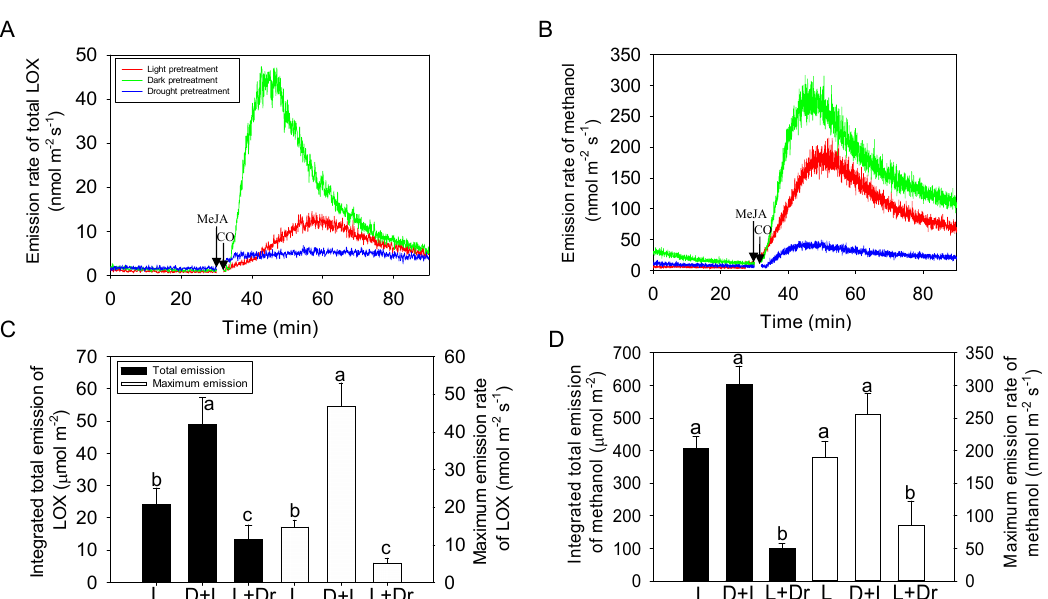
Figure 4. Sample emission time-courses of LOX compounds ( A ) and methanol ( B ) and corresponding average ± SE ( n = 3) total emission and maximum emission rates of LOX compounds ( C ) and methanol ( D ) in Cucumis sativus leaves following exposure to 20 mM MeJA at time 30 min. The leaves were subjected to three pretreatments, leaves illuminated before treatment (light pretreatment), leaves darkened for 30 min prior to treatment (dark) and leaves drought-stressed prior to treatment (drought; Figure 3 for details). Di ff erent letters (a, b, c) denote statistically significant di ff erences at p < 0.05 (ANOVA followed by Tukey test). The moment of MeJA spraying (30 min) is denoted. Break time during cuvette opening (about 2 min) is denoted by CO. L: light; D + L: Dark + Light; L + Dr: Light +